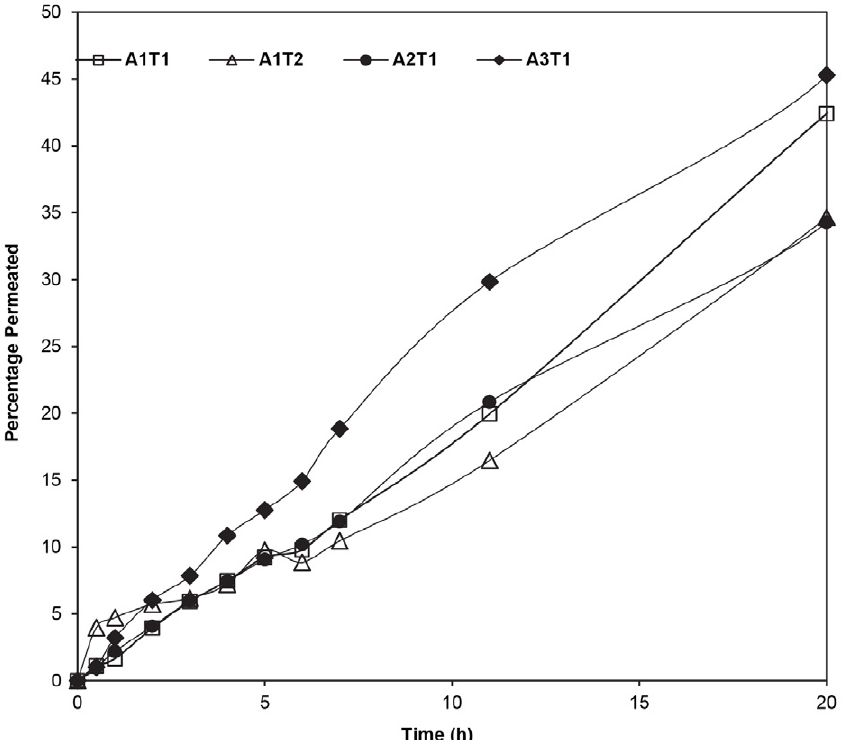
Figure 5. Ex vivo permeation study of the formulations through goat corneal